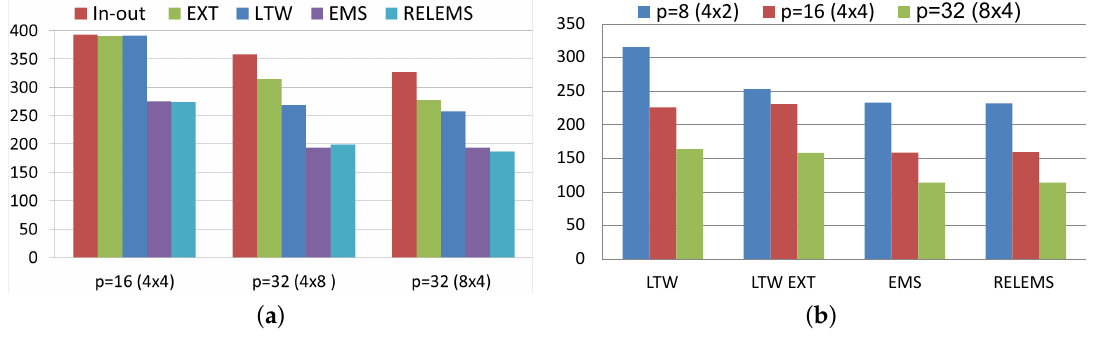
Figure 8. Non-stationary versus two-stage algorithms, (cid:101) = 10 − 6 , α = 0.98. ( a ) Parallel running times, uk-2007-05 matrix. ( b ) Parallel running times, webbase-2001